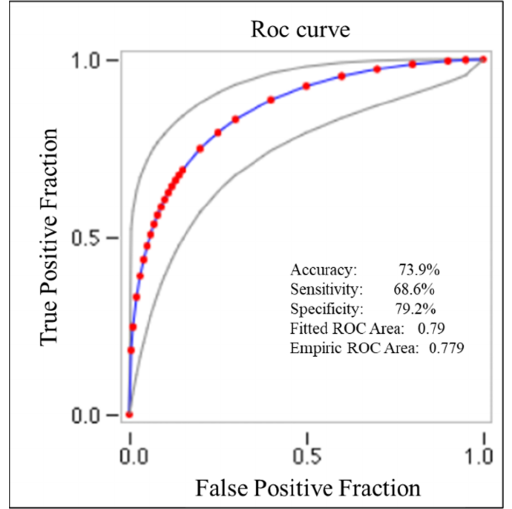
Figure 64. Validation of composite fl ood vulnerability index using ROC ‐ AUC (2015).